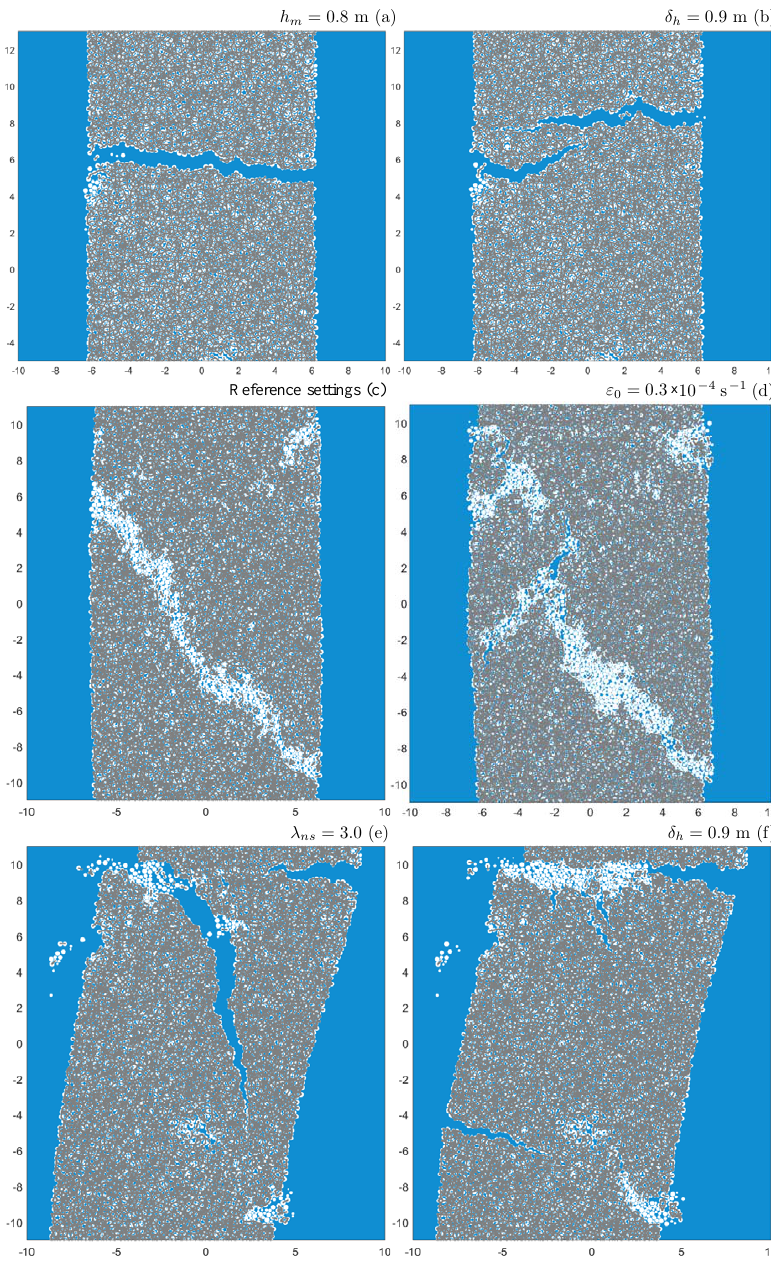
Figure 5. Example damage patterns obtained in simulations of an initially compact sample under uniaxial tensile (a, b) , uniaxial compres- sive (c, d) , and shear (e, f) strain. Thick gray lines show the bonds between grains. Model parameters that differed from the reference run are given with each panel. See Figs. S3–S5 for more